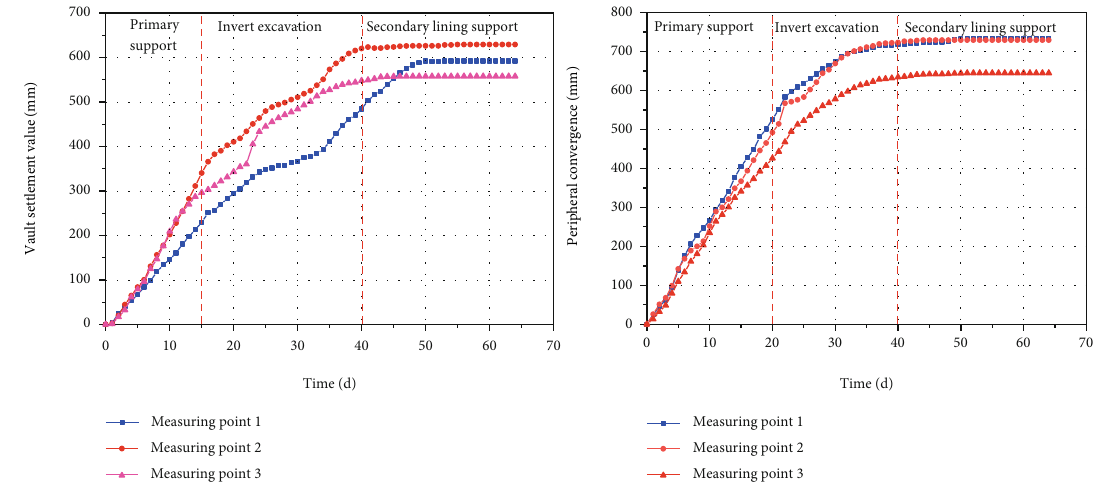
Figure 4: Crown settlement/peripheral convergence duration curve.